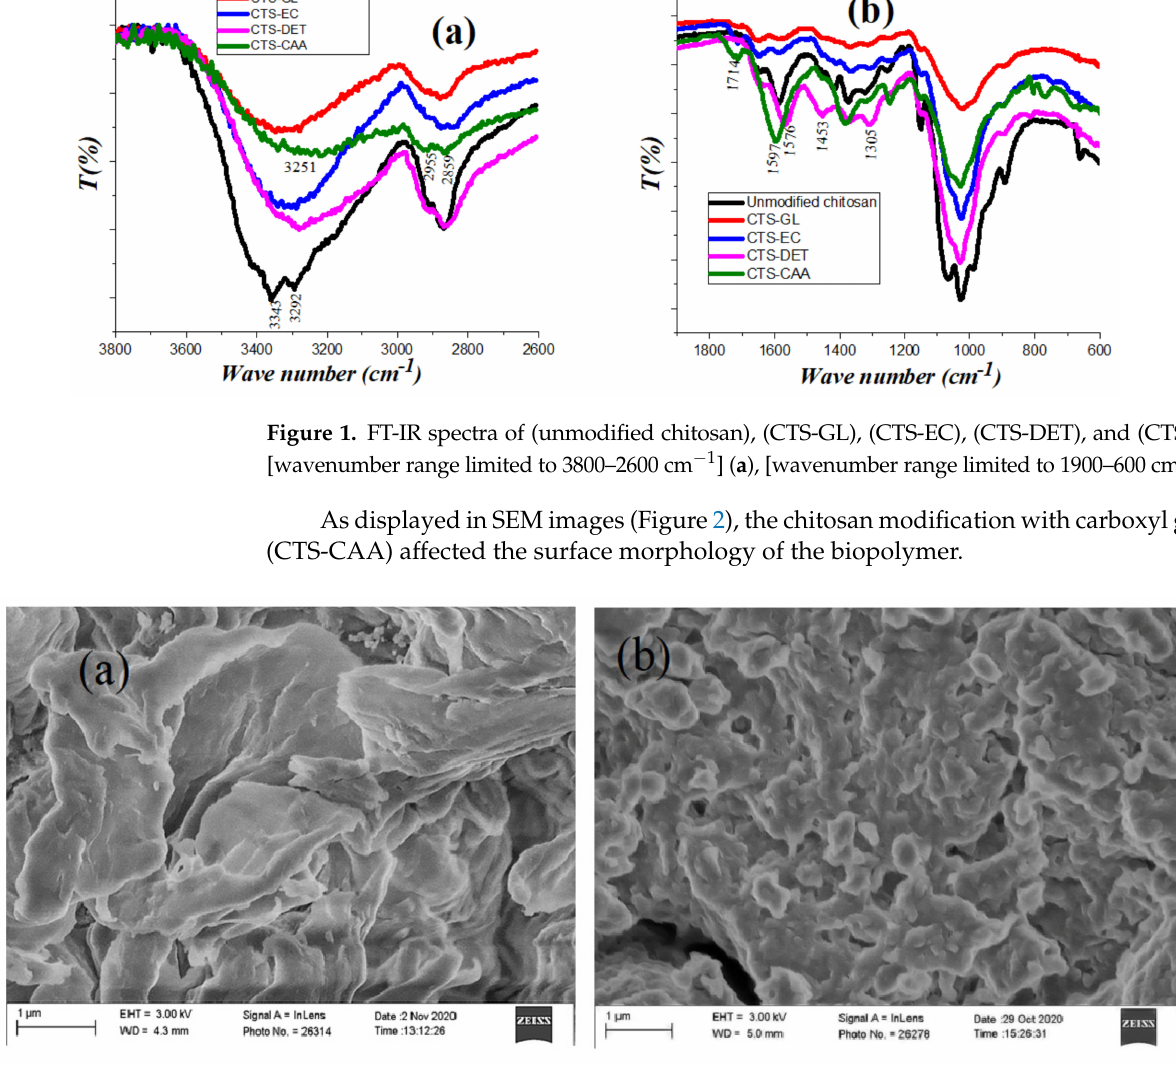
Figure 2. Scanning electron microscopy images for unmodified chitosan ( a ) and CTS-CAA ( b ). The titration curve of pH PZC estimation for (CTS-CAA) sample is presented in Figure 3. The obtained results can be useful to investigate the effect of the modification on the surface charge of